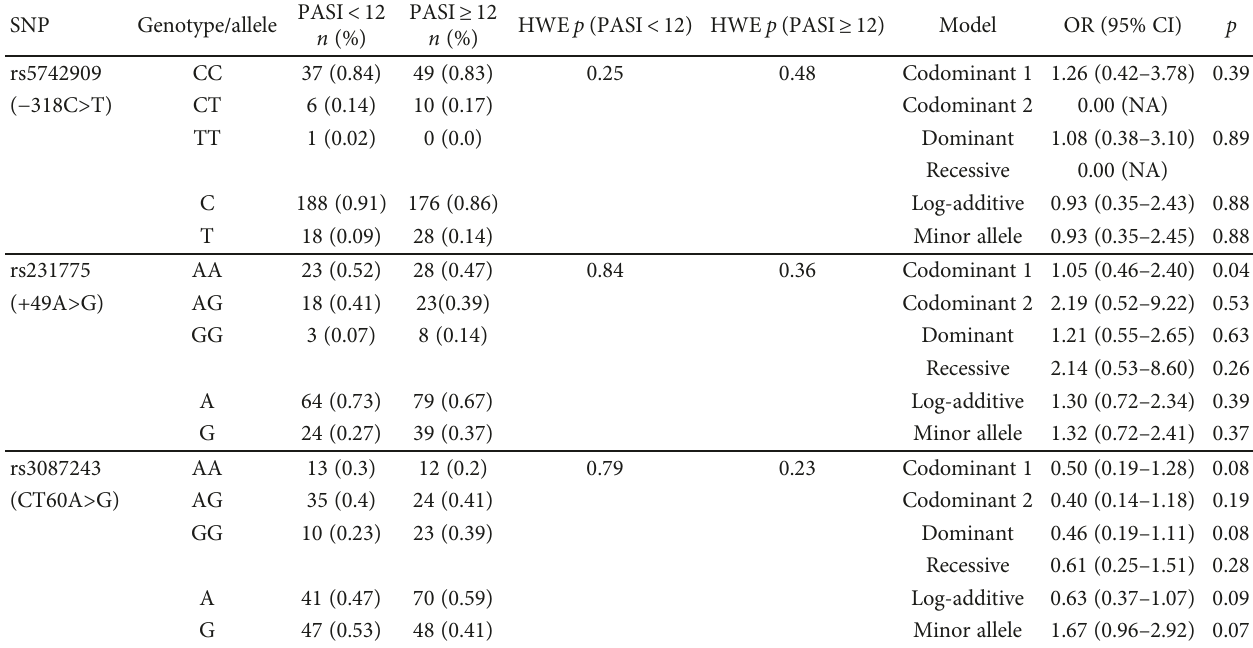
Table 5: Genotype and allele frequencies of CTLA-4 gene polymorphisms in PASI < 12 and PASI ≥ 12 and the association of these polymorphisms with the severity of